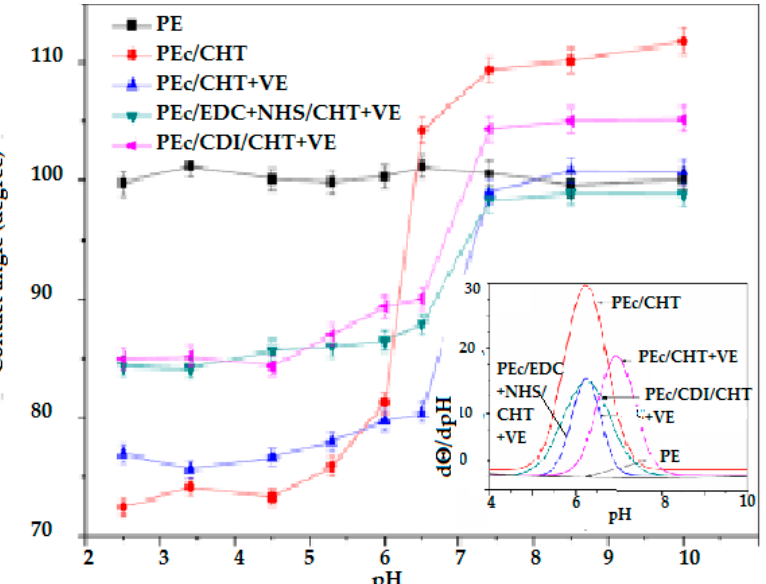
Figure 3. Contact angle ( θ ) versus pH titration curves and derivative curves of d θ /dpH (insert) for chitosan/vitamin E-coated PE films adapted from [157].